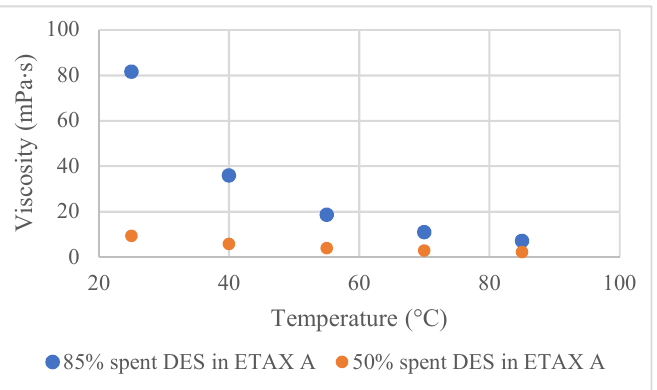
Figure 2. Influence of ethanol addition to the viscosity at different temperatures for the following spent DES in ethanol solutions: 85 vol% and 50 vol%.